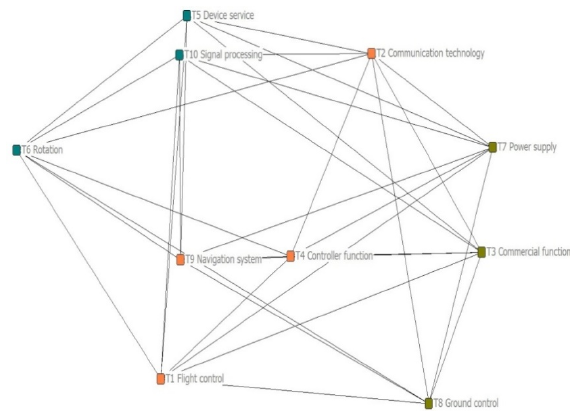
Figure 6. Technological portfolio of UAV.